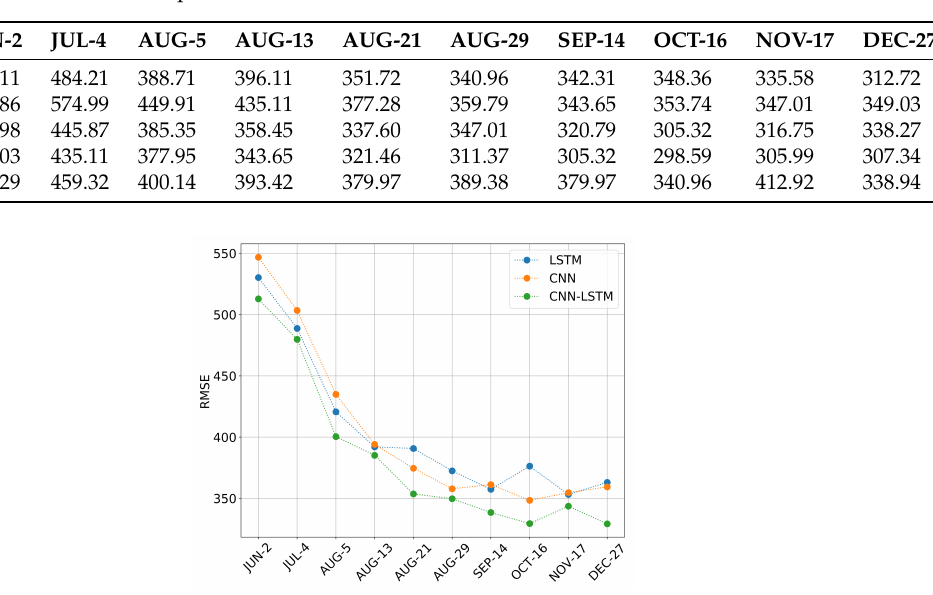
Figure 7. The averaged model performance measured in RMSE from 2011 to